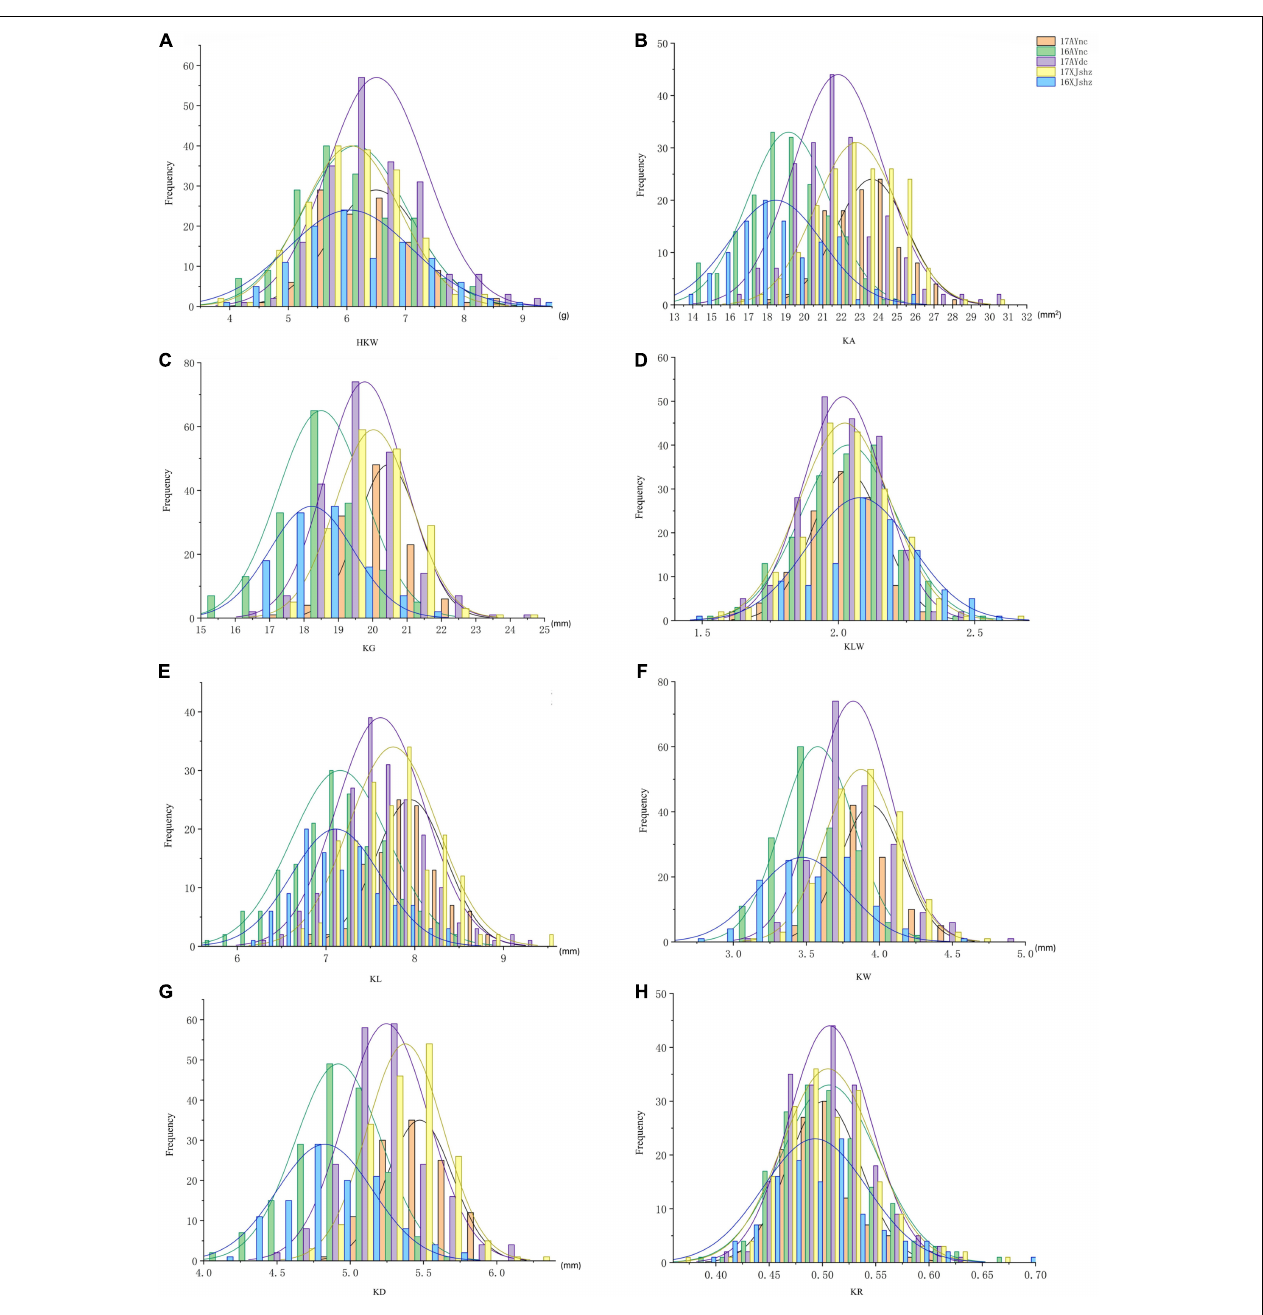
FIGURE 1 | Frequency map of 8 traits in different environments of 250 BILs. Different colors represent different environments. (A) HKW. (B) KA. (C) KG. (D) KLW. (E) KL. (F) KW. (G) KD. (H) KR. See the footnote in Table 1 for explanations of the abbreviations.